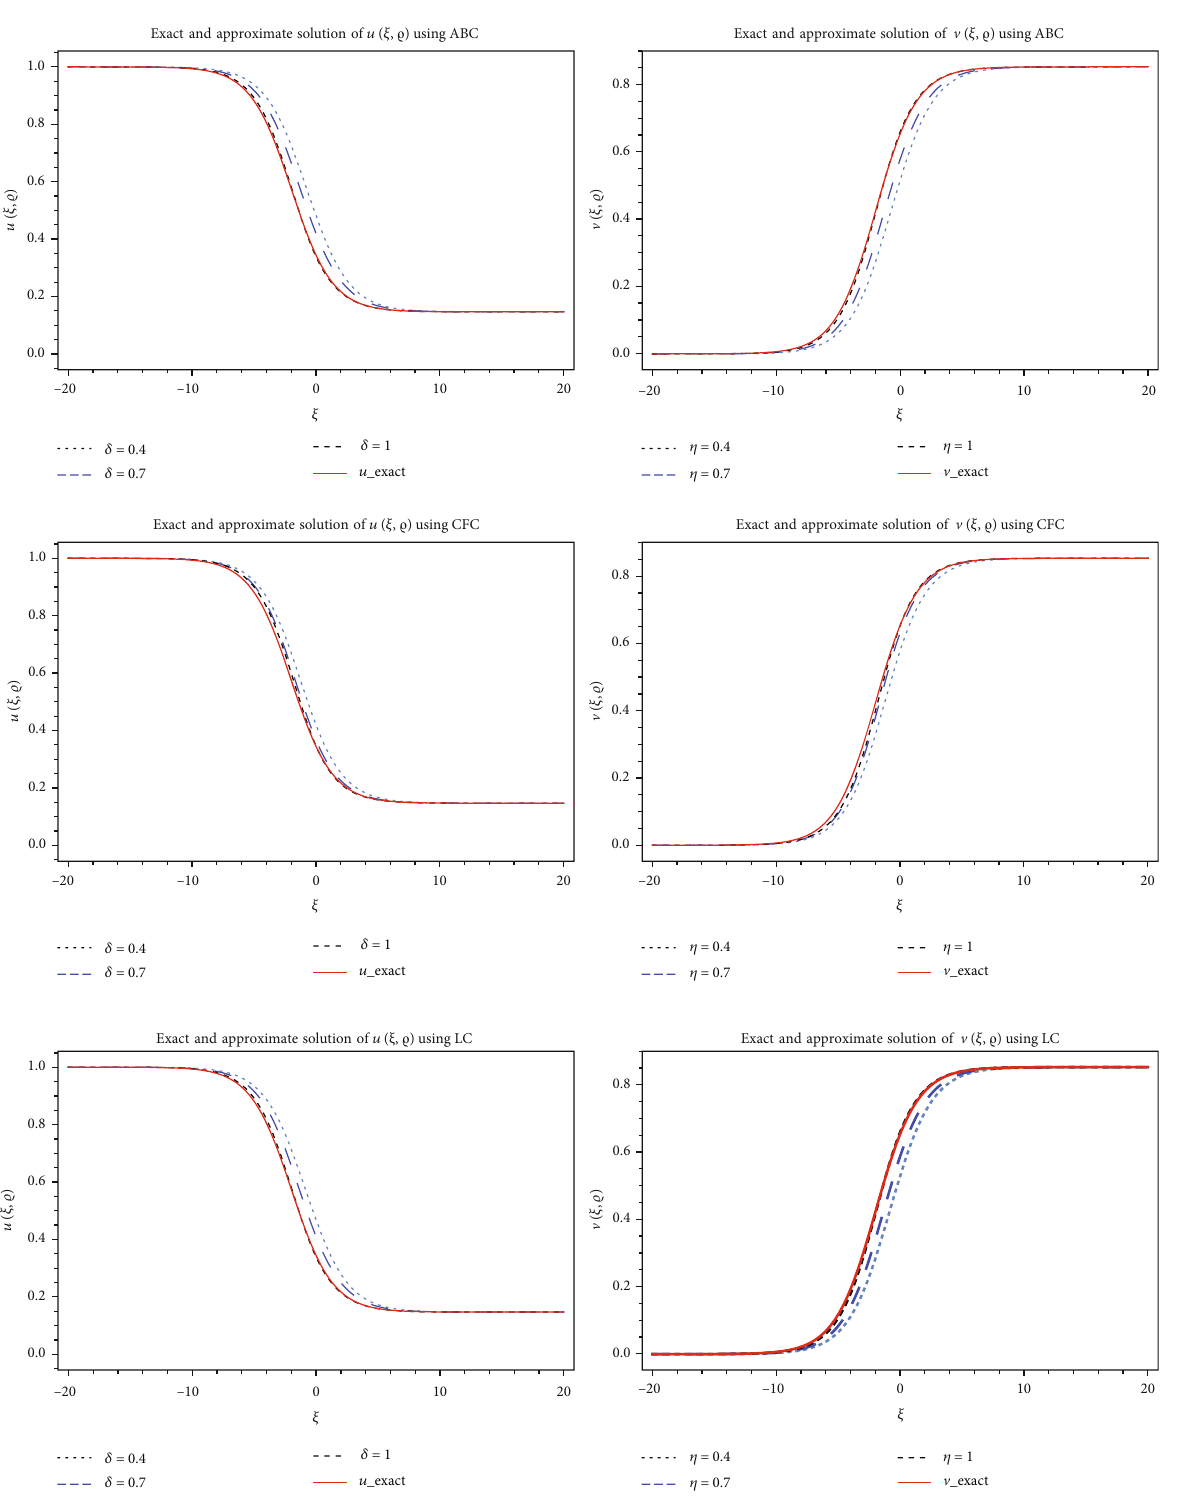
Figure 3: Di ff erent values of δ and η using the ABC, CFC, and